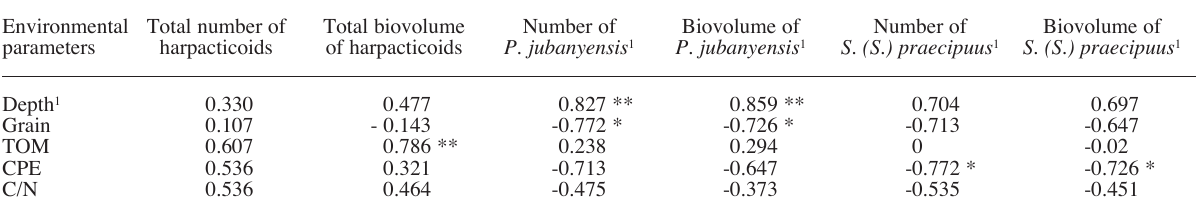
T ABLE 6. – Results of the Spearman rank analysis of environmental parameters versus animal data; 1 = data sets for which the correlation instead of r had to be calculated; ** = α : 0.05; * = α : 0.1 for the two-sided coefficient r S.B S